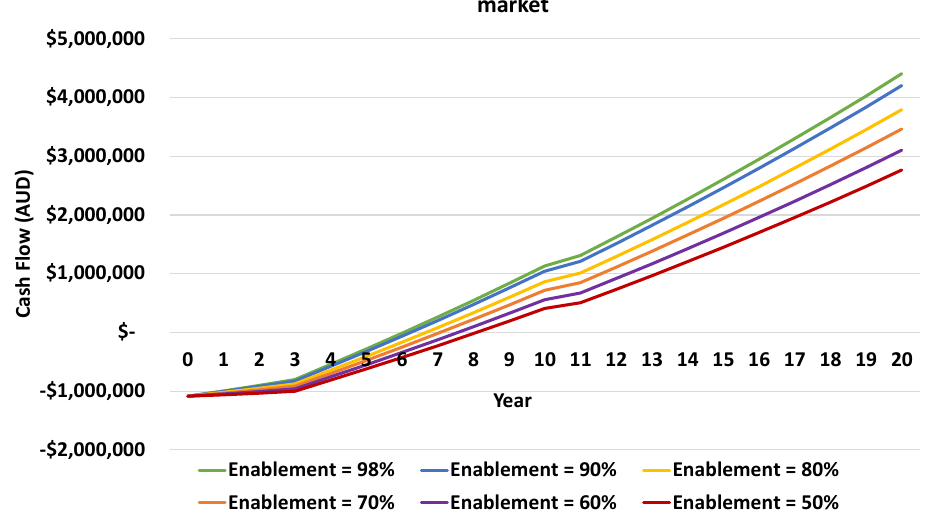
Figure 7. The cash flow for the VPP at different levels of enablement rate (%) when participating in LFAS and energy markets.